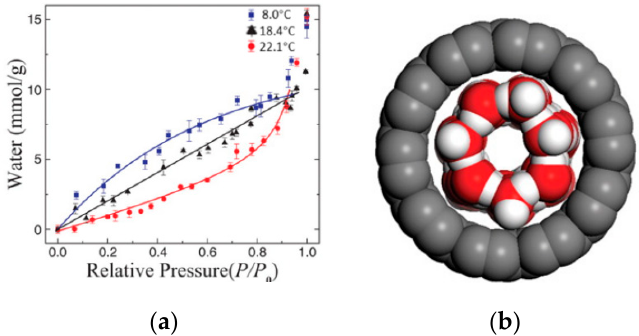
Figure 9. ( a ) Water adsorption isotherms inside single-walled carbon nanotubes (SWNTs) as a function of RH measured at different temperatures, including 8.0 °C (squares), 18.4 °C (triangles), and 22.1 °C (circles). ( b ) Schematic illustration showing a monolayer water adsorbed inside SWNTs at 8.0 °C. Reprinted from Ref. [19,71], Copyright 2008, with permission from Science.